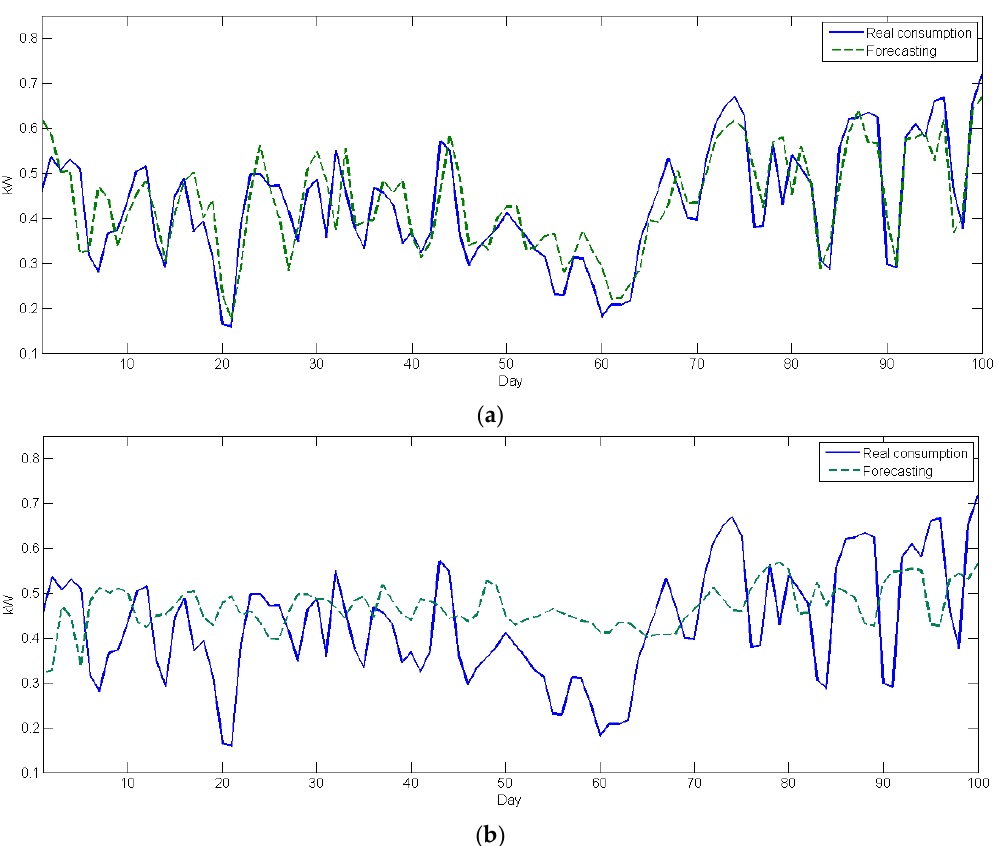
Figure 11. Best prediction ( a ) and worst prediction ( b ) of the next 100 days for the normalized data of Building 5 using the NAR model.